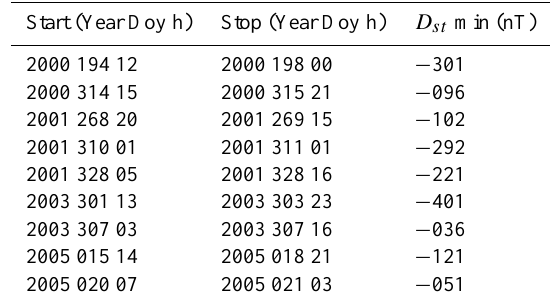
Table 1. ACE/SWEPAM failures.